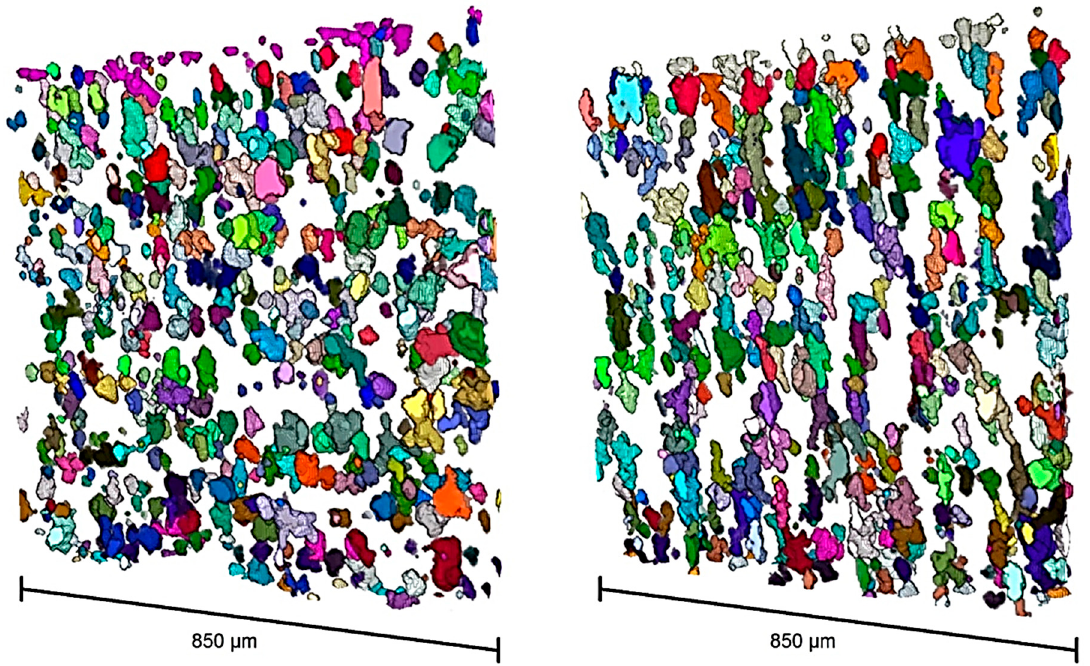
Figure 6. The 3D reconstructed images of tomography data after particle separation. ( Left ) Initial microstructure of particles distribution under 0-mT magnetic field and ( Right ) microstructure of the same sample under 250-mT magnetic field with particles chains [22] (reprinted with permission from Elsevier TM ).